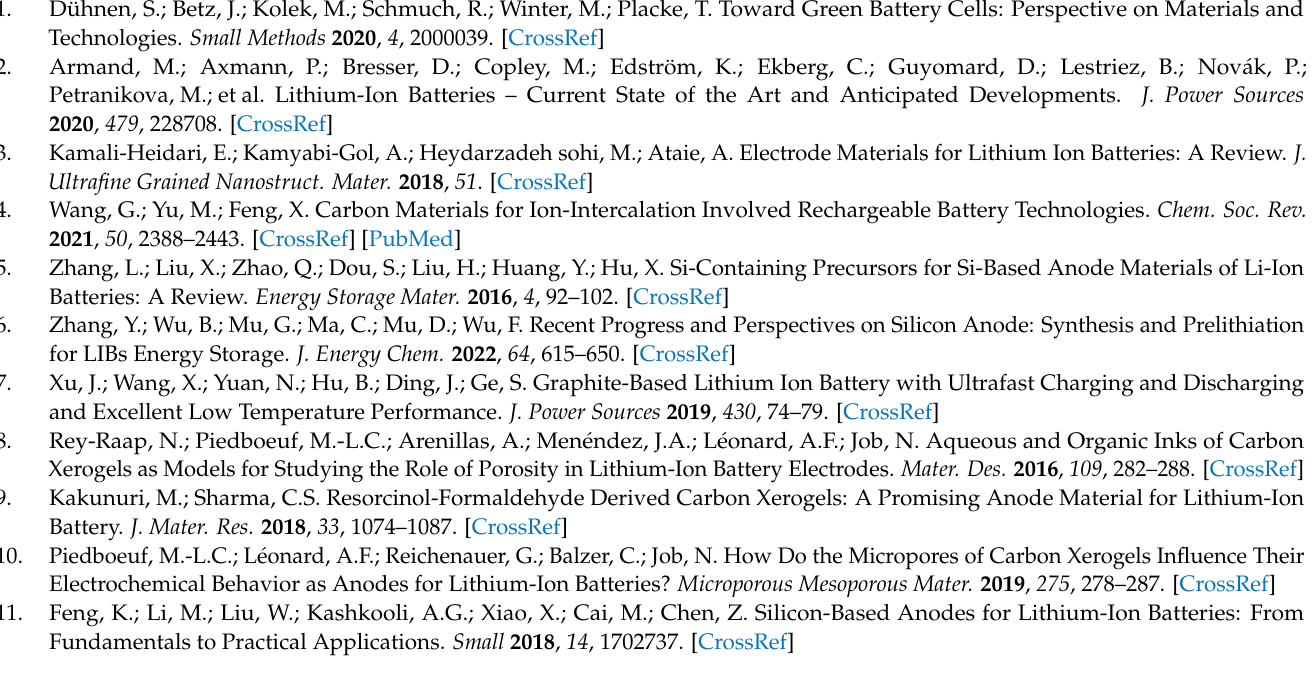
Figure S5: Galvanostatic performance of rSG-5, rHG/85-5 and commercial graphite Timrex KS6; Figure S6: Effect of precoating the electrode support with a NaCMC-C65